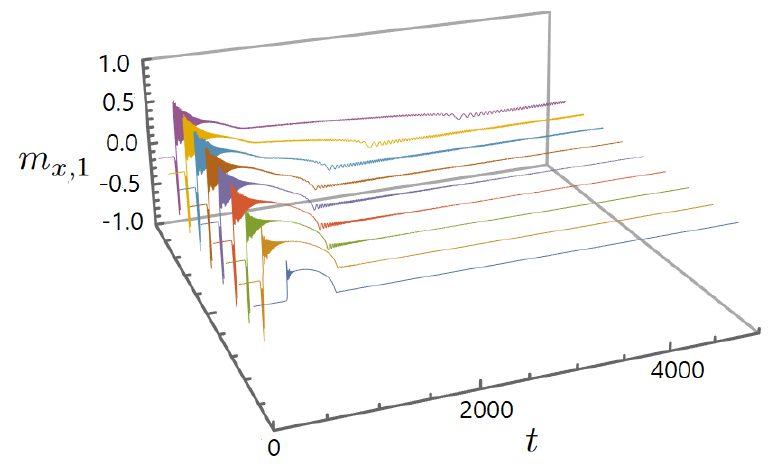
Figure 4: Time evolution of the order parameter m , compare with Fig. 2, for r x ,1 in Eq. (27) sets to r = 1 (blue curve), r = 5 (orange curve), r = 10 (green curve), r = 20 (red curve), r = 40 (blue curve), r = 80 (brown curve), r = 160 (light- blue curve), r = 320 (yellow curve) and, finally, r = 640 (purple curve). The pulse = 0.2 and τ = 1000, see Eq. (19). parameters are E 0